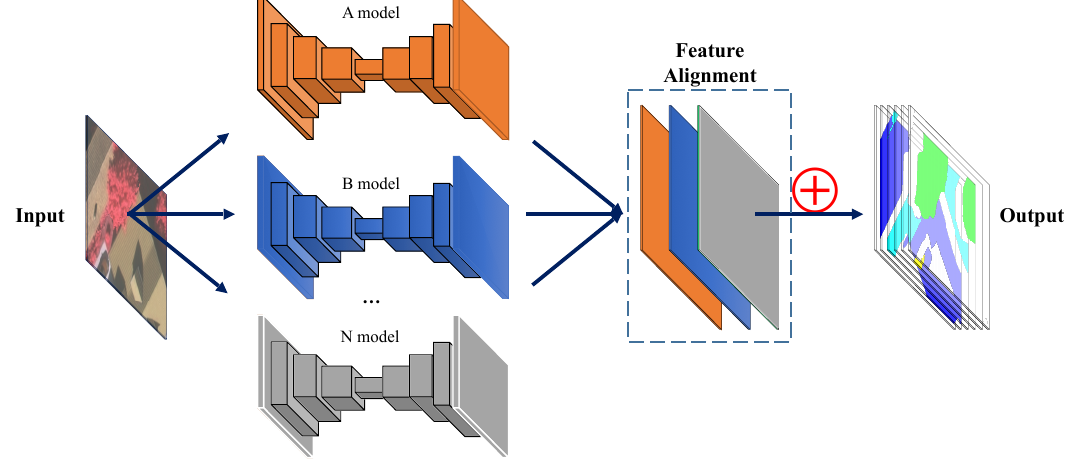
Figure 3. Proposed stacked fully convolutional networks(SFCN). The SFCN contains a framework for feature extraction using N number of fully convolutional networks(A, B, ..., N model), and a framework for feature alignment and final output